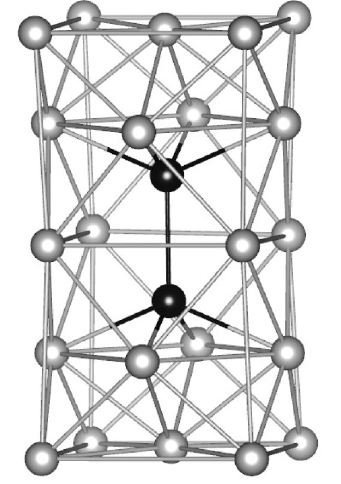
Figure 1. <100> interstitialcy in a molecular-dynamic model of copper